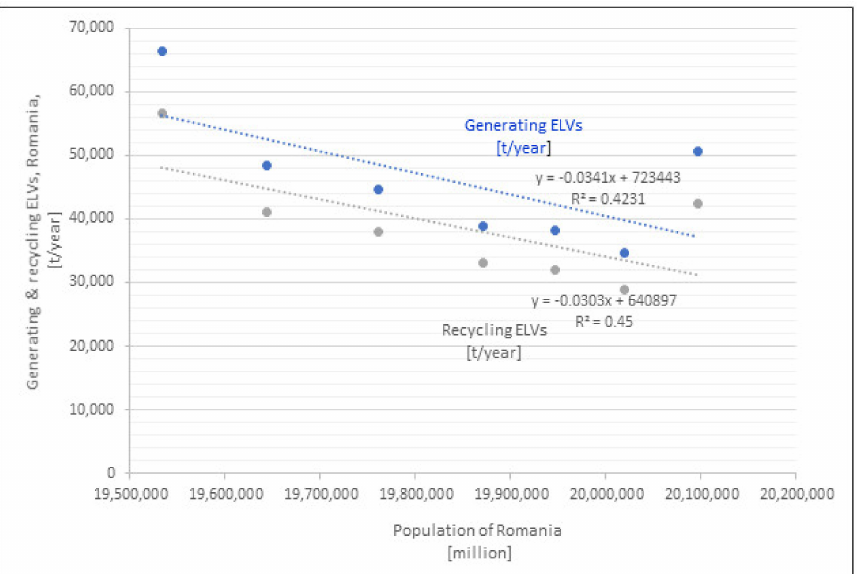
Figure 10. Correlation between ELVs generating and recycling in Romania during 2012–2018 and the population in the same